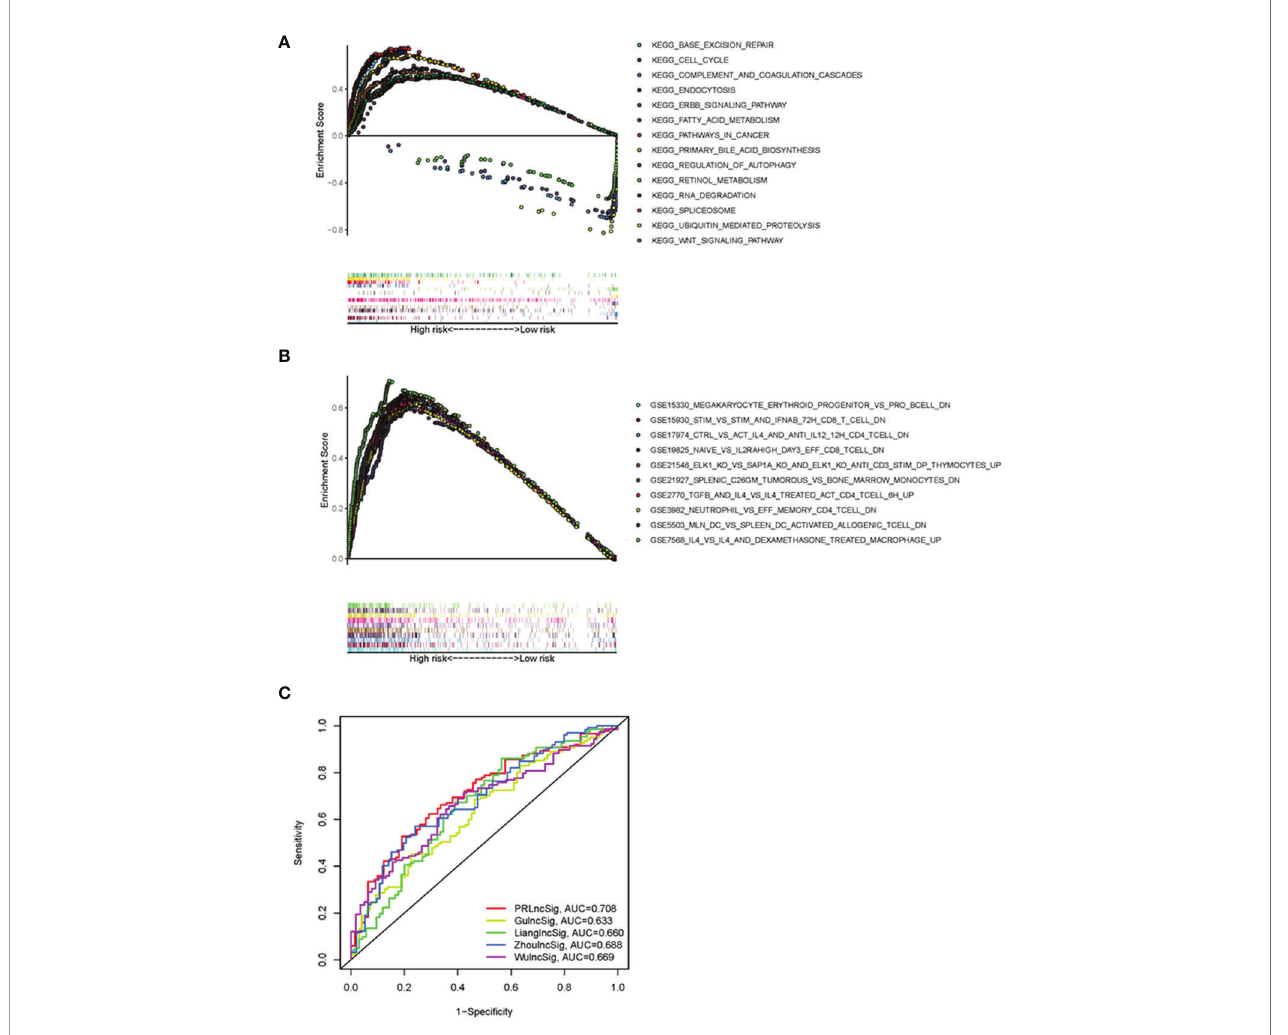
FIGURE 7 | Functional GSEA analysis of PRlncSig and model comparisons. (A) Representative KEGG pathways signi fi cantly enriched in high-risk patients. (B) Immune-related signatures signi fi cantly enriched in high-risk patients. (C) ROC analysis of the prediction of 3-year survival by PRlncSig and four other